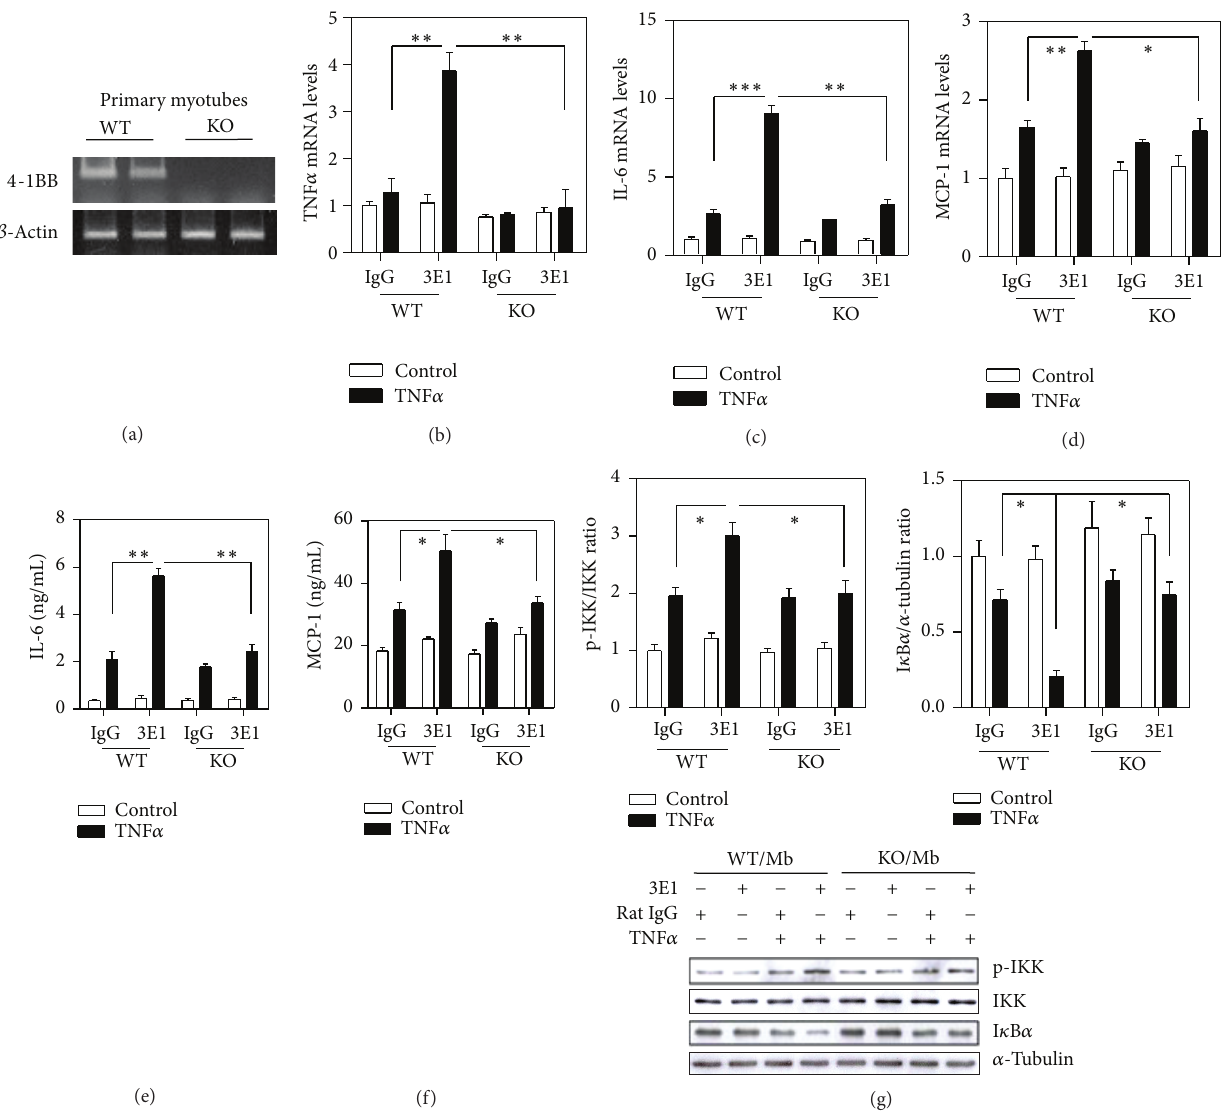
Figure3:Expressionofinflammatorycytokinesinprimarymyotubestreatedwith3E1.Three-dayprimarymyotubesderivedfrom4-week-old WT and 4-1BB-deficient mice. (a) Representative bands of 4-1BB mRNA were determined by semiquantitative RT-PCR. Primary myotubes were pretreated with 10ng/mL TNF 𝛼 in DMEM containing 0.1% FBS for 12h. Then the cells were washed twice with PBS and given 10 𝜇 g/mL 3E1 or 10 𝜇 g/mL rat IgG (control) in serum-free DMEM for 24h (b–f) or 3 h (g). (b–d) qRT-PCR analysis of mRNA for the inflammatory cytokines TNF 𝛼 , IL-6, and MCP-1. ((e) and (f)) Levels of release of inflammatory cytokines IL-6 and MCP-1 in the culture media were measured by ELISA. (g) Expression of phosphorylated IKK 𝛼 / 𝛽 , IKK 𝛽 , I 𝜅 B 𝛼 , and 𝛼 -tubulin proteins was determined by Western blotting using the indicated antibodies (lower panel). Band intensities were measured densitometrically using ImageJ. Relative intensities of the bands were displayed as fold of control (upper panels). Data are means ± SEM of three independent triplicate experiments. ∗ 𝑃 < 0.01 , ∗∗ 𝑃 < 0.01 , and ∗∗∗ 𝑃 < 0.001 significantly different between 3E1- and rat IgG-treated groups or between WT and KO